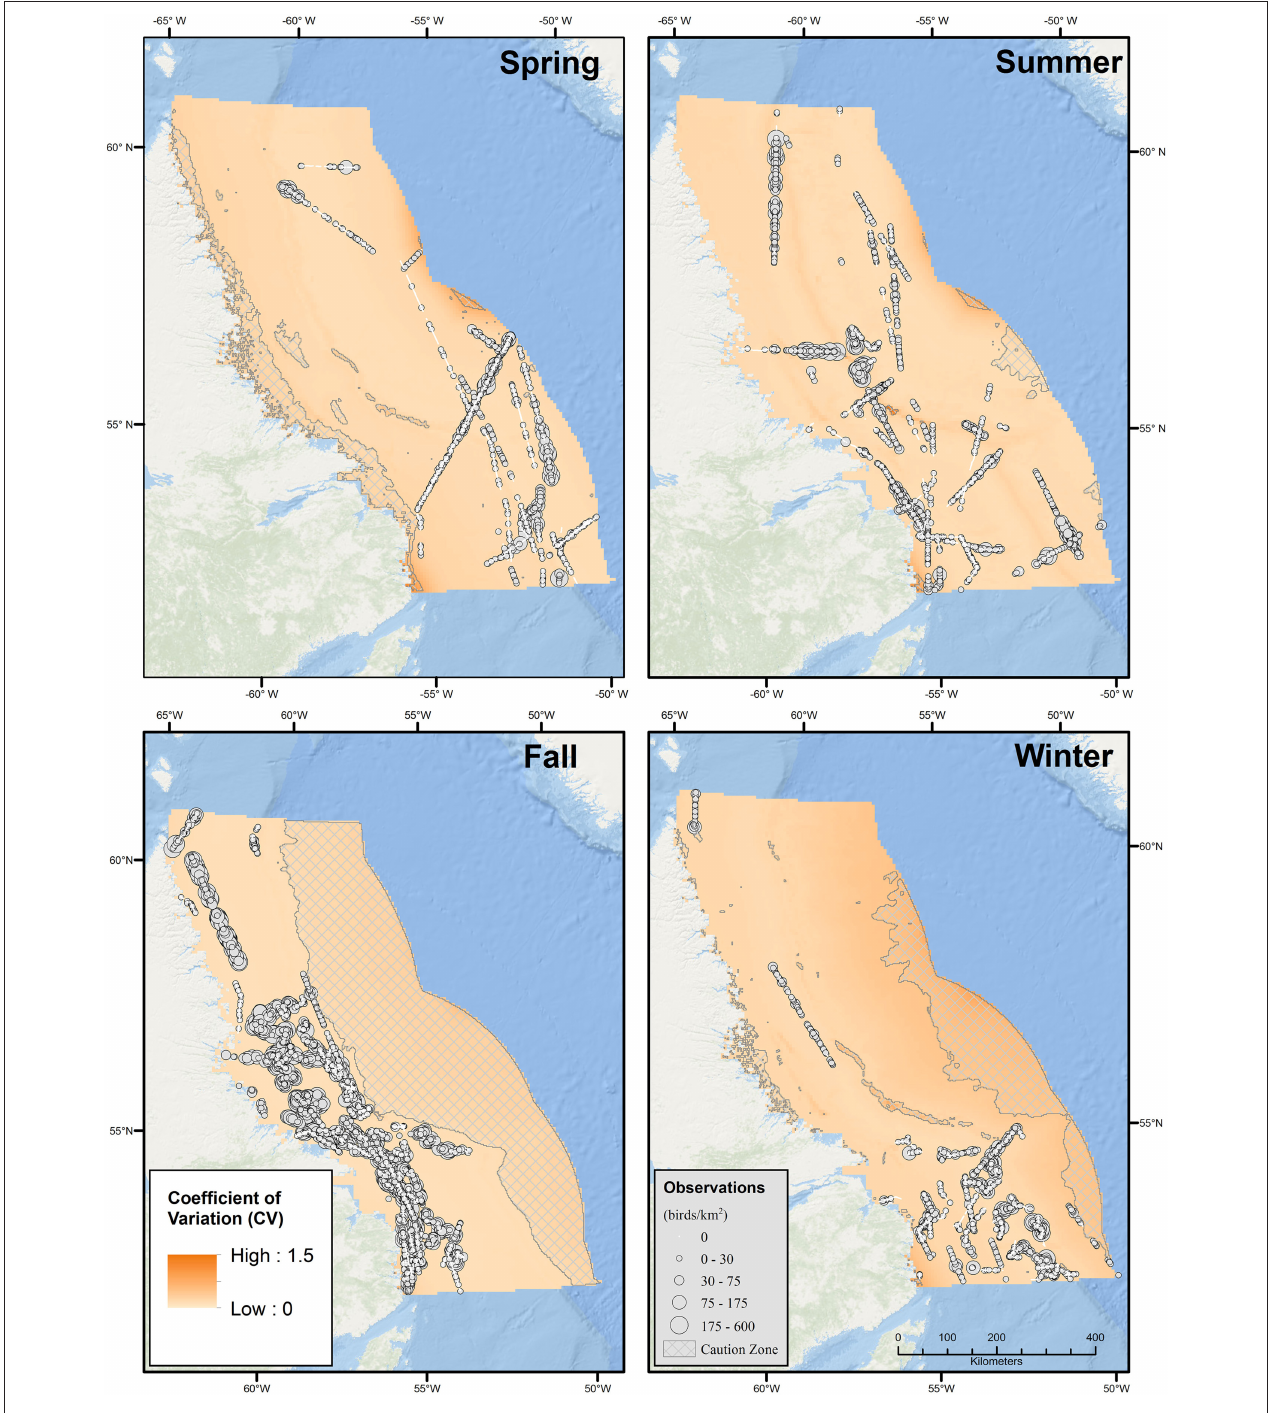
FIGURE 3 | Seasonal bird observations and coefficient of variation (CV) for predicted densities of all seabirds based on Generalized Additive Models (GAMs). Seasons were defined as Summer (June-August), Fall (September-October), Winter (November-March), and Spring (April-May).